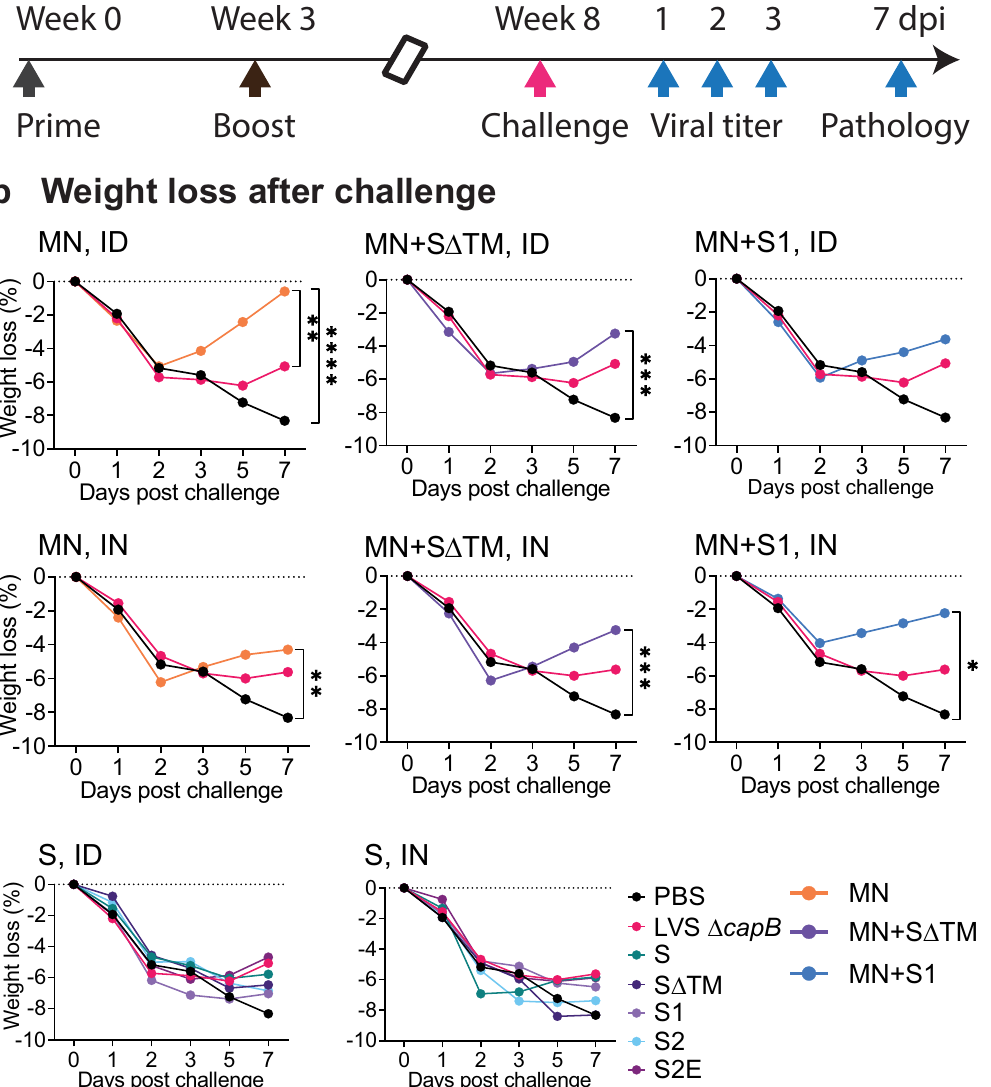
Fig. 2 Experimental schedule and weight loss after challenge. a Experiment schedule. Golden Syrian hamsters (8/group, equal sex) were immunized ID or IN twice (Week 0 and 3) with rLVS Δ capB/ SCoV2 vaccines, singly and in combination (MN + S Δ TM; MN + S1); challenged IN 5 weeks later (Week 8) with 10 5 pfu of SARS-CoV-2 (2019-nCoV/USA-WA1/2020 strain), and monitored closely for clinical signs of infection including weight loss. Single vaccines expressed the S, S Δ TM, S1, S2, S2E, or MN proteins, as indicated. Control animals were sham-immunized (PBS) or immunized with the vector (LVS Δ capB ) only. All hamsters were assayed for oropharyngeal viral load at 1, 2, and 3 days post challenge (dpi). Half of the hamsters ( n = 4/group) were euthanized at 3 days post challenge for lung viral load analysis and half ( n = 4/group) were monitored for weight loss for 7 days and euthanized at 7 days post challenge for lung histopathology evaluation. b Weight loss after challenge. Data are mean % weight loss from 0 days post challenge. * P < 0.05; ** P ≤ 0.01; *** P < 0.001; **** P ≤ 0.0001 comparing means on Day 7 post challenge by repeated measure (mixed) analysis of variance model. Sham vs. MN: P < 0.0001, ID route; P < 0.01, IN route. The standard errors were omitted in the graphs for daily and assayed for viral load. At 3 and 7 days post challenge, half of the animals in each group were euthanized and evaluated for lung viral load and lung histopathological changes, respec- tively (Fig. 2a).